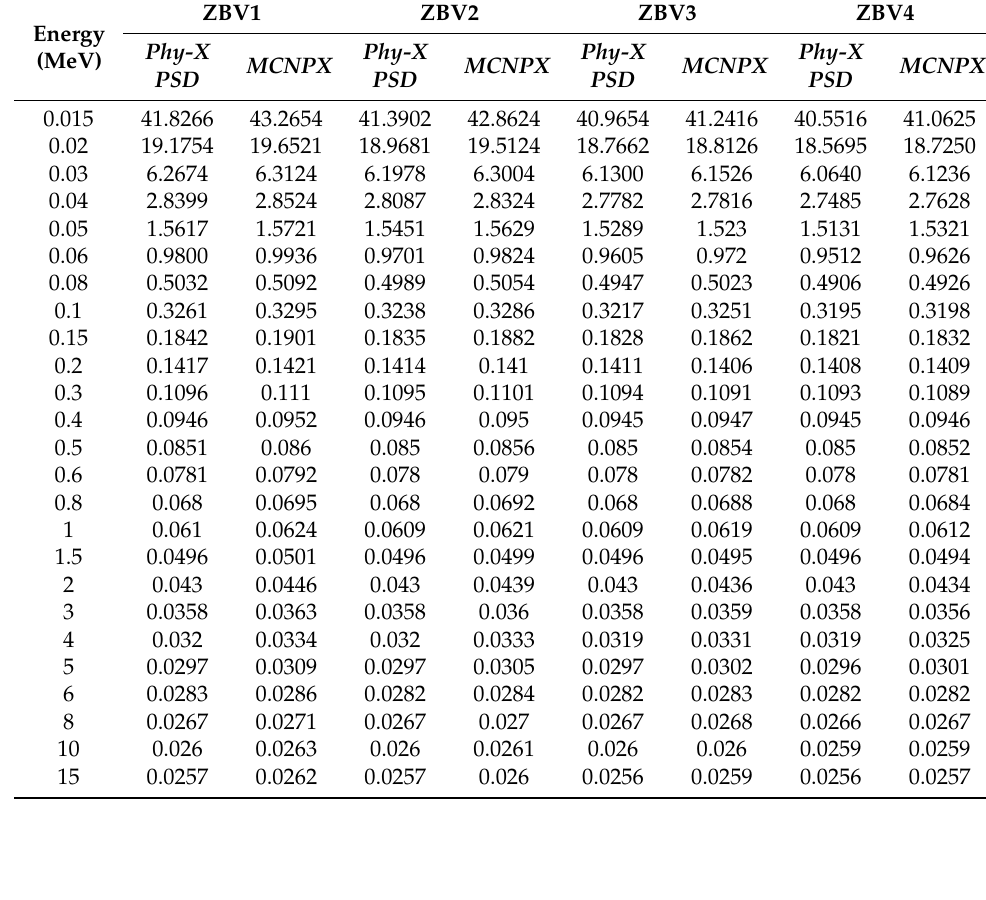
Table 2. Mass-attenuation coefficients (cm 2 /g) of the studied glass samples obtained using the MCNPX code and Phy-X PSD program.